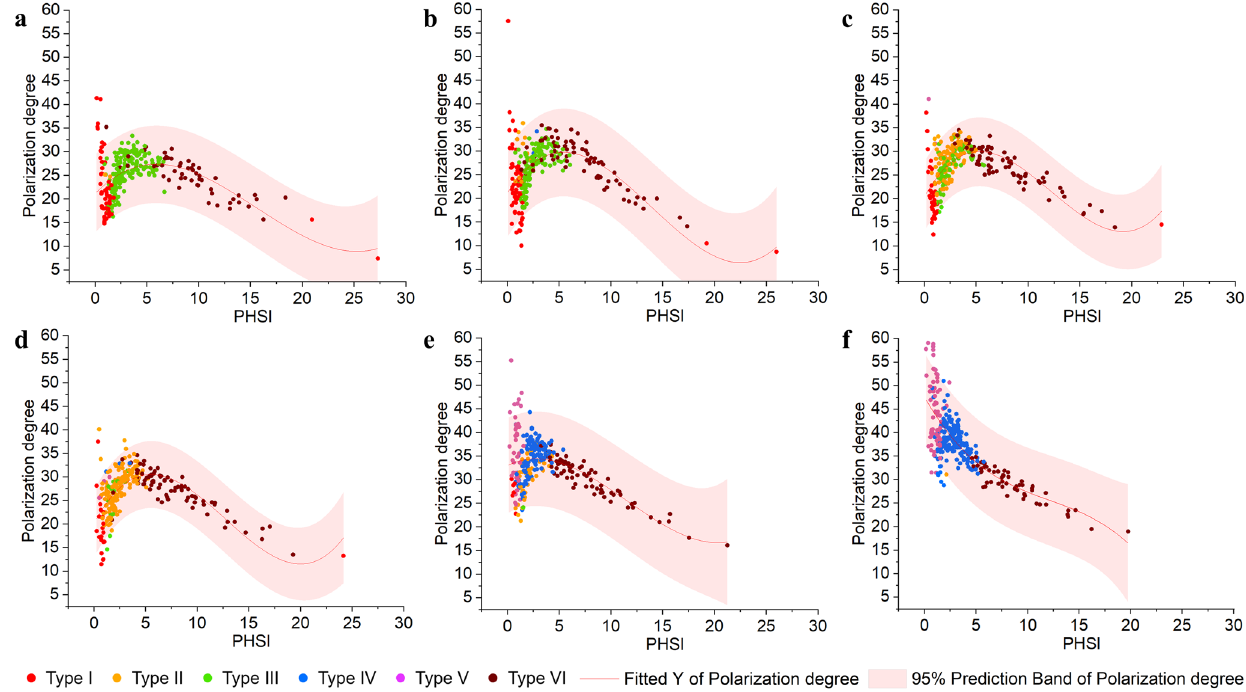
Fig. 7 Correlation between PHSI and polarization degree. Sub-panels a – f depict the cubic polynomial fi t plots drawn from 2015 – 2020 with PHSI as the independent variable and the polarization degree as the dependent variable. The fi gure was developed by the authors using Origin Pro Version